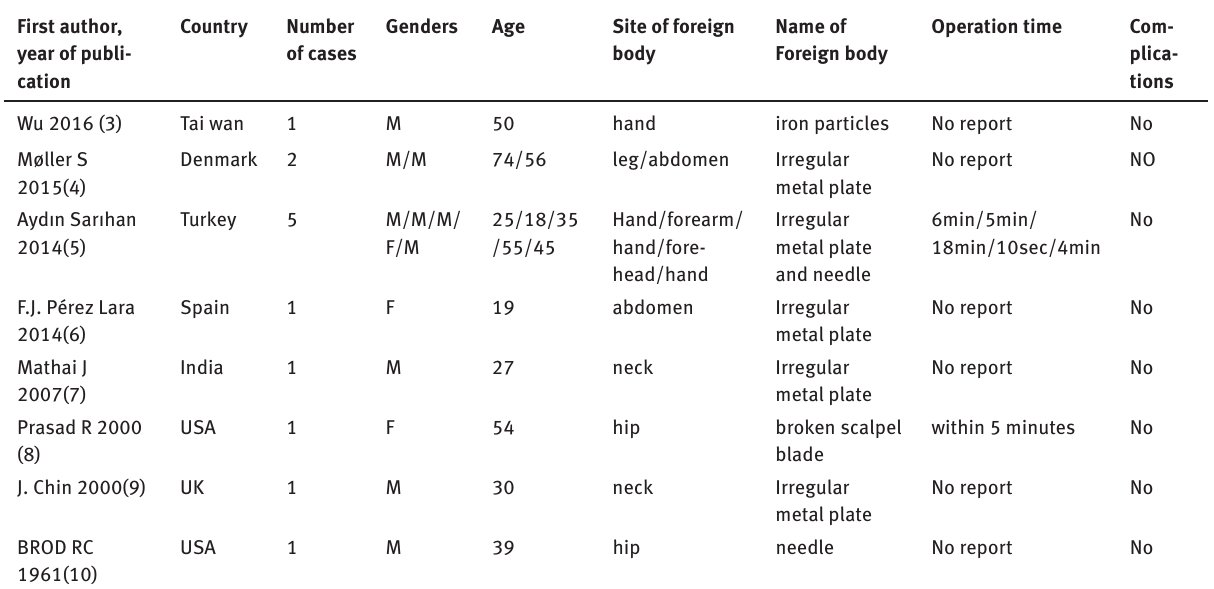
Table 1: Characteristics of 8 studies related to retrieval of foreign bodies from the soft tissue with the help of